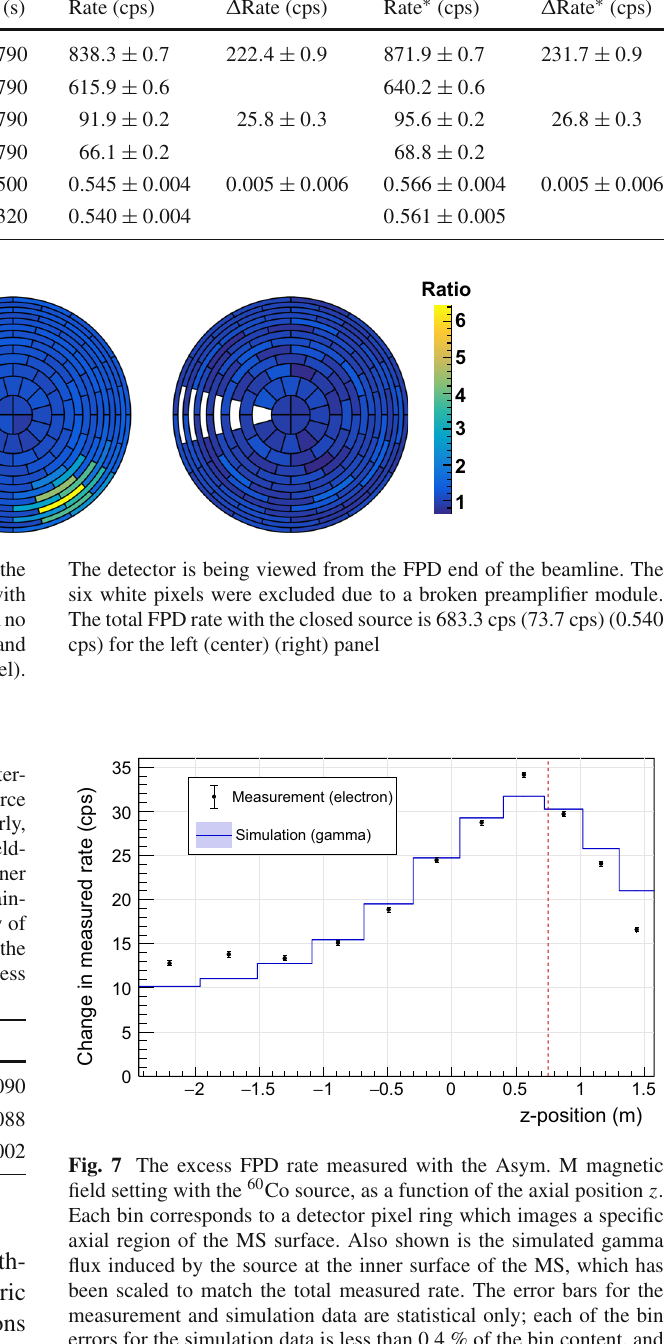
Table 4 Results from the FPD measurements with the 60 Co source, where the rates are measured in units of counts per second (cps). Rate is the raw result from the detected counts and measurement duration Δ t , while Rate ∗ is corrected for the broken preamplifier module. The errors